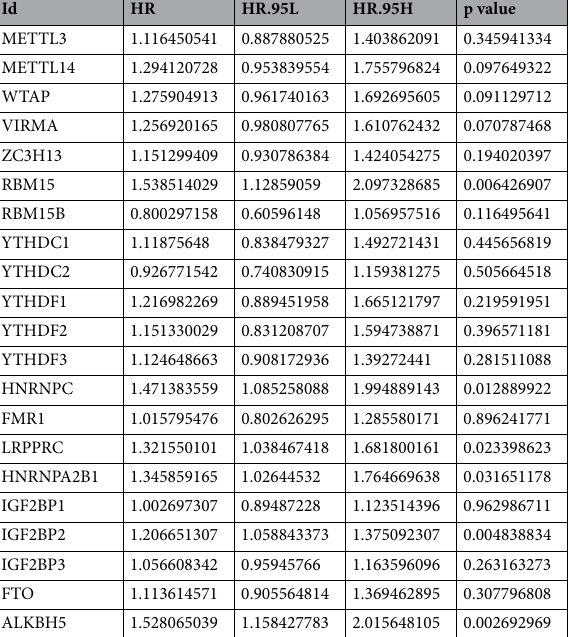
Table 1. Univariate Cox regression analyses of 21 m 6 A regulator genes. HR value > 1: high-risk gene; HR value < 1: low-risk gene. p < 0.05 was statistically